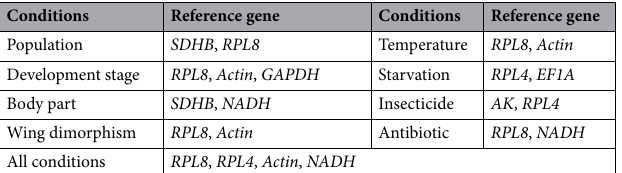
Table 2. Recommended reference genes for M. dirhodum under various experimental